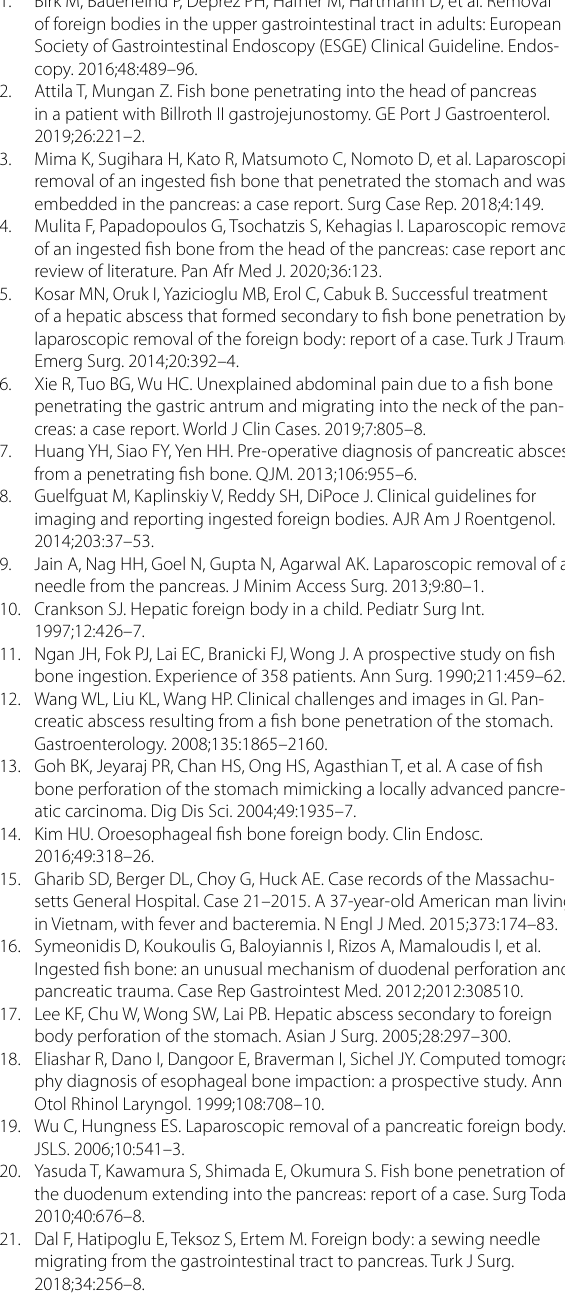
characteristics and surgical